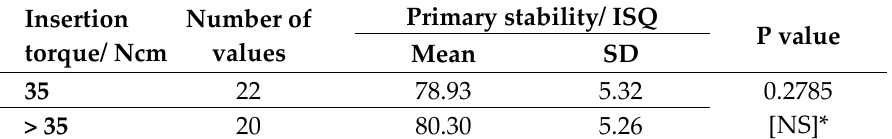
Table (2): The differences of the secondary stability ISQ value in relation to the recipient jaw. Recipient